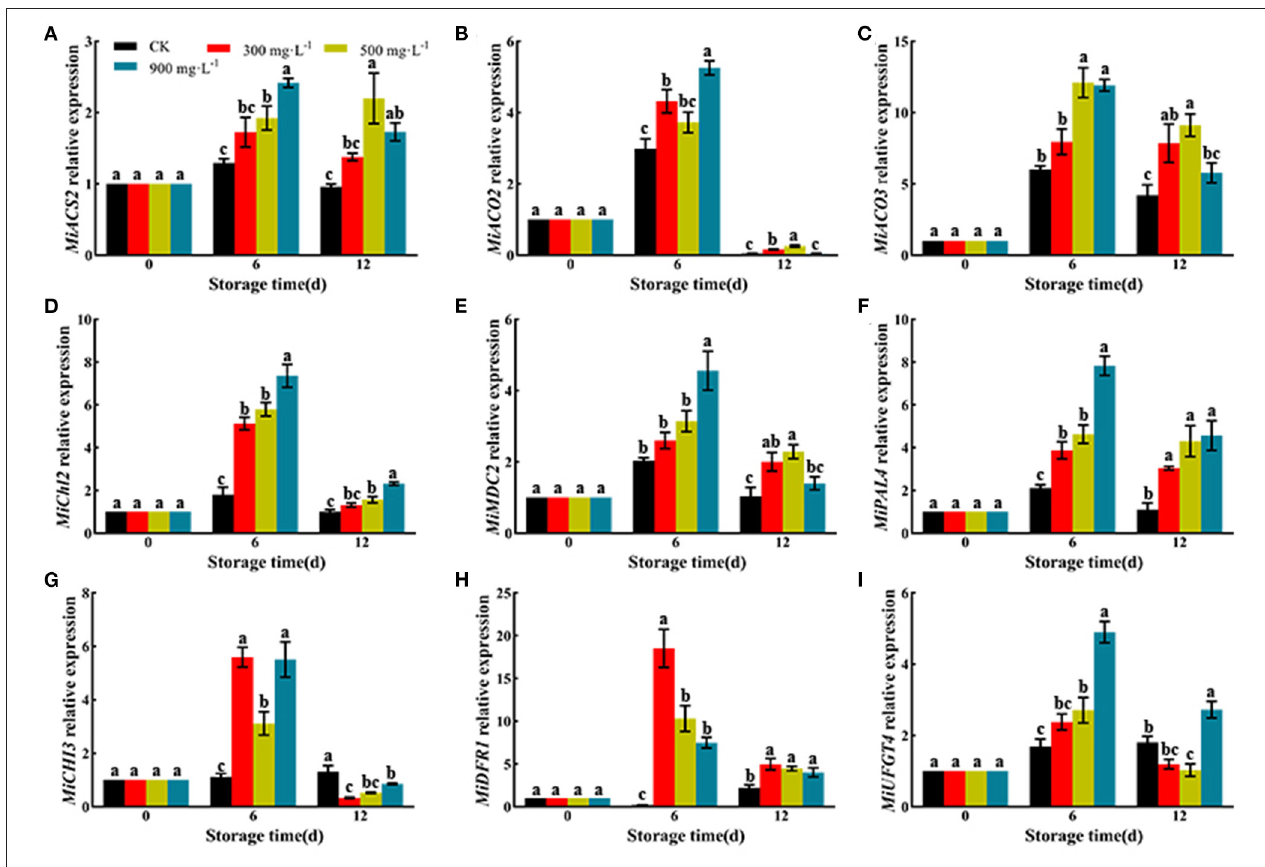
FIGURE 6 | Relative expression of genes involved in ethylene biosynthesis and pigment mechanism including MiACS2 (A) , MiACO2 (B) , MiACO3 (C) , MiChl2 (D) , MiMDC2 (E) , MiPAL4 (F) , MiCHI3 (G) , MiDFR1 (H) , and MiUFGT4 (I) . Values followed by different letters are significantly different based on Duncan’s multiple range tests at P < 0.05. The error bars indicate the standard deviations of three biological